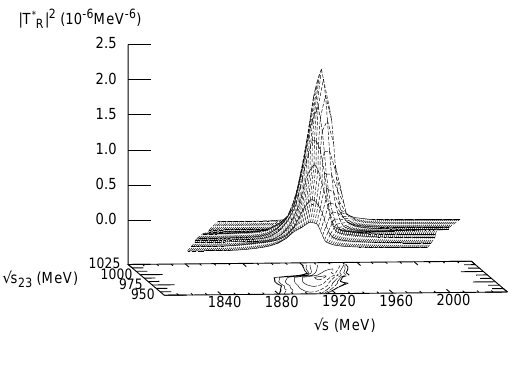
Fig. 4. A possible N ∗ in the NK ¯ K channel around 1920